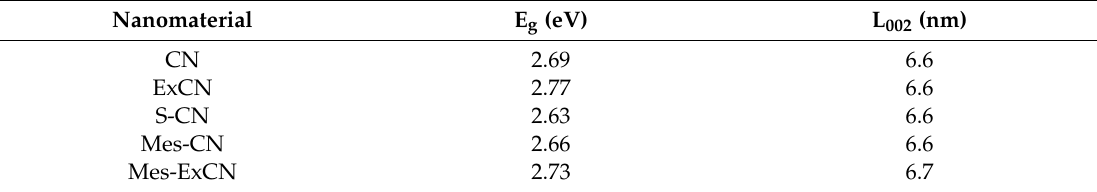
Table 2. Evaluated values of band gap energy and crystallite size of prepared nanomaterials. Nanomaterial